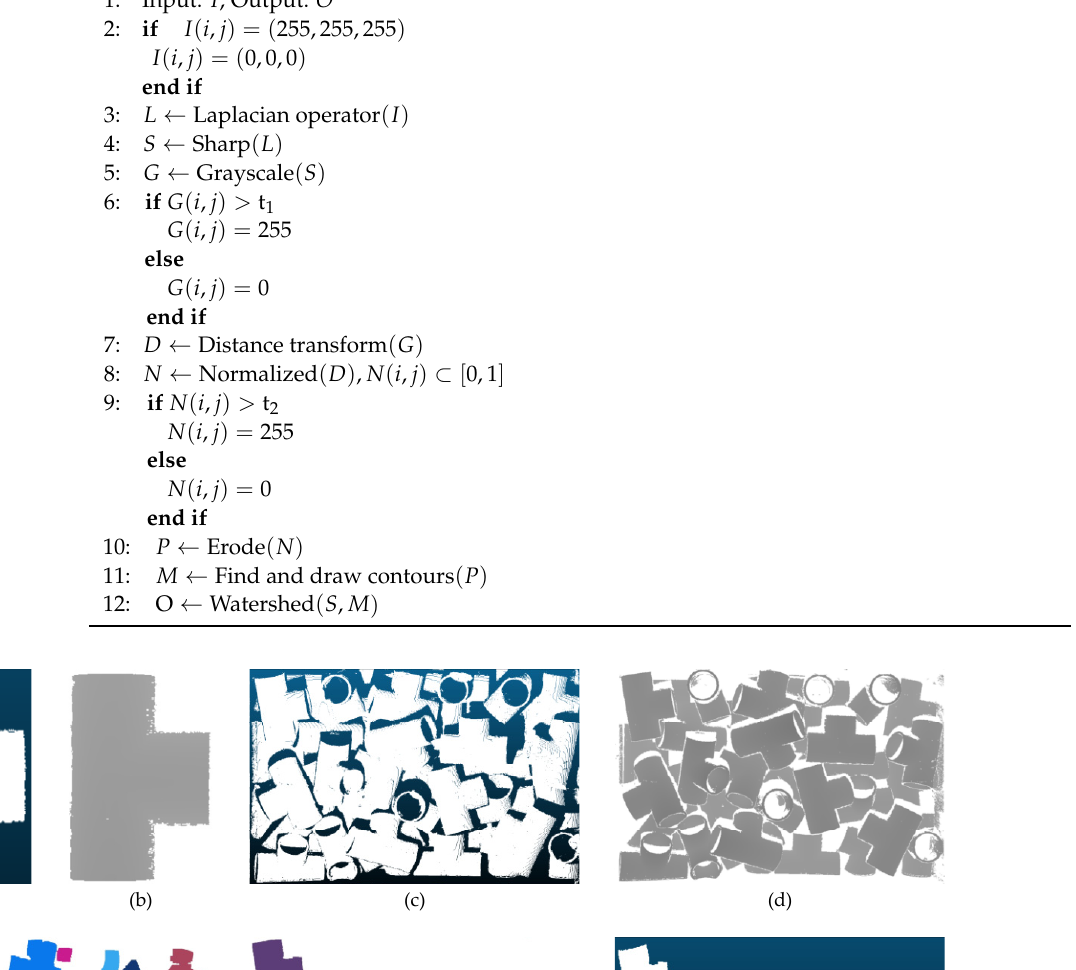
Algorithm 1 Watershed Segmentation Algorithm Based on Distance Transform